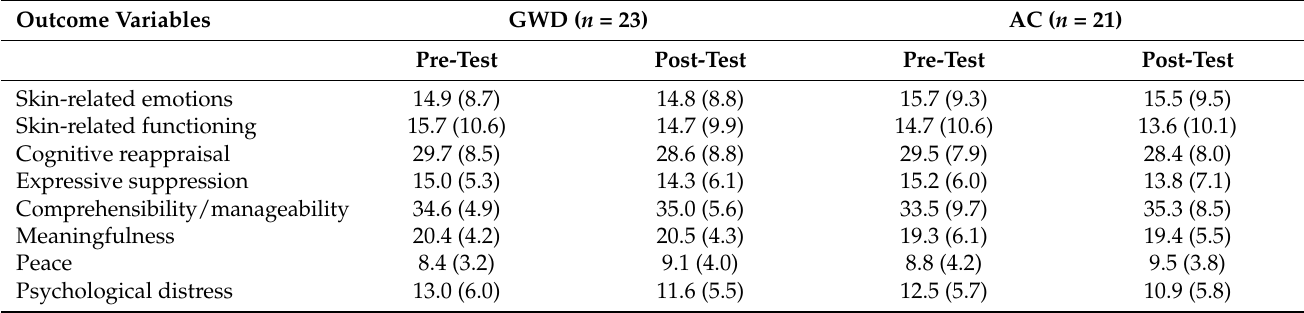
Table 2. Means and standard deviations of outcome variables in GWD and control groups.